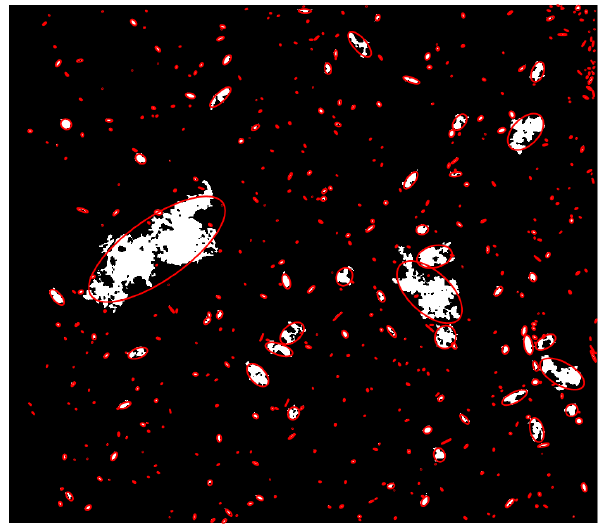
Figure 6. Binary image with superimposed fitted ellipses plotted over each detected particle or